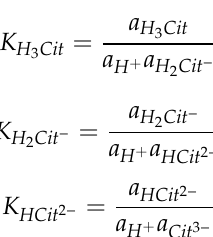
Figure 4. Total dissolved COM in ultrapure water measured by ICP-OES as a function of temperature (blue triangles). Simulated values using the K sp values of Streit et al. [22] (black stars) and the fit of the ICP-OES results with the simulated total soluble Ca concentration after estimation of K sp ,0 and ∆ H R using the Van’t Hoff equation (solid magenta line).